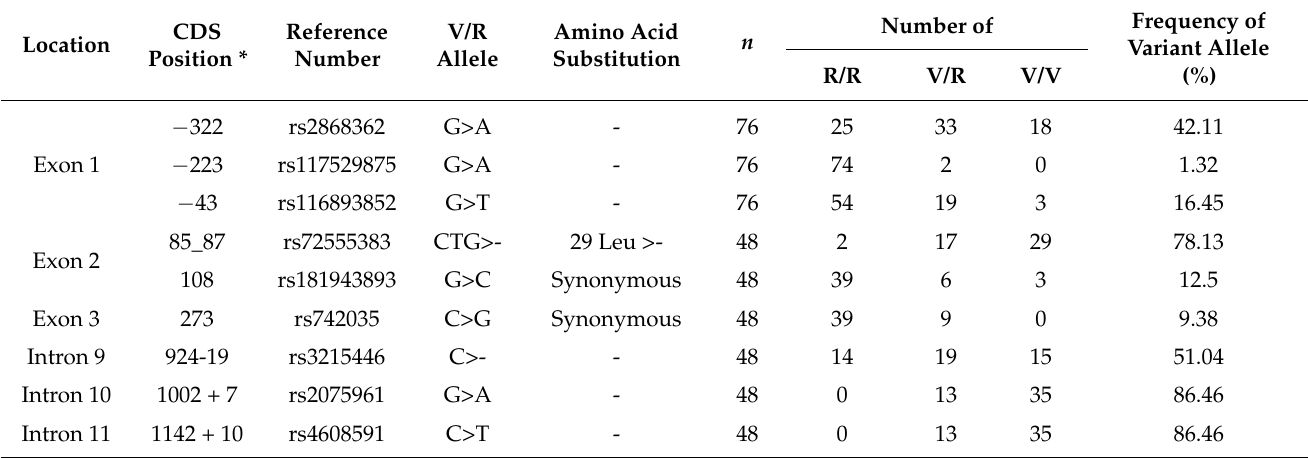
Table 3. Cathepsin A genetic variations in healthy Japanese volunteers.